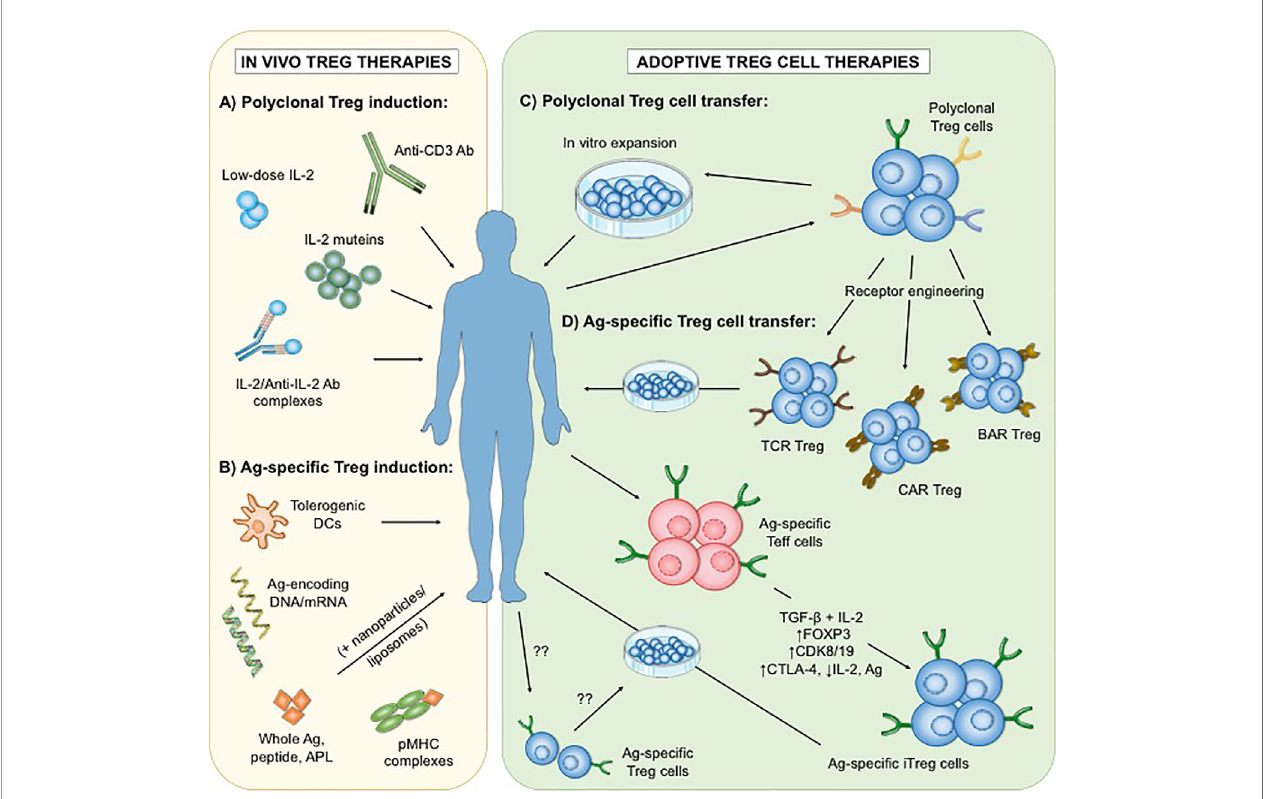
FIGURE 1 | Different approaches of polyclonal and antigen-speci fi c Treg cell-based therapies. To date, two main strategies have been developed: the administration of immunomodulatory agents that enhance the number and/or function of Treg cells in vivo (A, B) , and the adoptive transfer of in vitro expanded Treg cells (C, D) . Interventions that increase polyclonal endogenous Treg cells in vivo involve low-dose interleukin-2 (IL-2), mutant IL-2, IL2/Anti-IL-2 Ab complexes as well as selective depletion of Teff cells by Anti-CD3 Ab (A) . In contrast, applications of antigen-based treatments could lead to the enhancement of antigen-speci fi c Treg subsets (B) . On the other hand, adoptive Treg cell therapies rely on the optimal isolation and expansion of Treg cells in vitro . Thus far, clinical trials in autoimmunity have only utilized expanded polyclonal Treg cell populations (C) . However, antigen-speci fi c Treg cells can be generated in vitro (D) by genetic insertion of synthetic receptors (including engineered T cell receptors (TCR), chimeric antigen receptors (CAR) or B cell antibody receptors (BAR)), or by transformation of antigen-speci fi c effector T (Teff) cells into induced Treg (iTreg) cells via stimulation in the presence of transforming growth factor beta (TGF-ß) and IL-2, transgenic FOXP3 overexpression, blockade of cyclin-dependent kinase 8 (CDK8) and CDK19 signaling, or a combination of cytotoxic T lymphocyte antigen 4 (CTLA-4) overexpression, IL-2 ablation and antigenic stimulation. The isolation and expansion of endogenous antigen-speci fi c Treg cells remains technically challenging. Ag, antigen; DCs, dendritic cells; APL, altered peptide ligands; pMHC, peptide-major histocompatibility